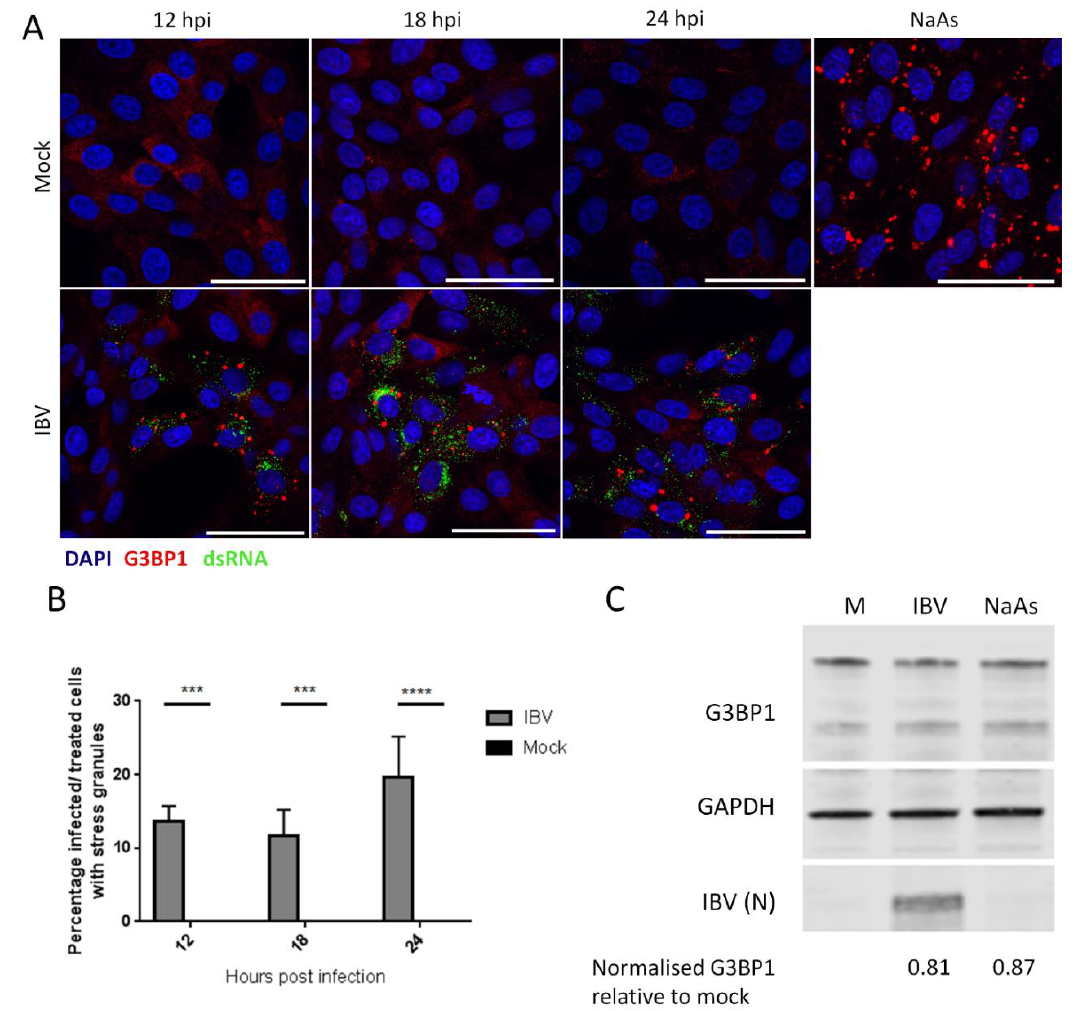
Figure 1. IBV (infectious bronchitis virus) infection induces stress granules in a proportion of infected cells. ( A ) Vero cells were mock infected or infected with IBV. At 12, 18 and 24 hpi, stress granules (SG) were detected using an anti-G3BP1 antibody (red) and IBV infection was detected with an anti-dsRNA antibody (green). Nuclei were stained with DAPI (blue). Positive control cells were treated with sodium arsenite (NaAs) to induce eIF2 α -dependent SG. Scale bar indicates 50 µ m. ( B ) Images in ( A ) were quantified by manual counting of SG positive cells, identified by counting infected or treated cells with G3BP1 foci. A minimum of 100 cells were counted from three independent replicates. The mean and standard deviation is shown. Asterisks indicate statistical significance, as measured by one-way ANOVA, *** represents p < 0.005 and **** represents p < 0.0005, respectively. ( C ) Vero cells were mock infected or infected with IBV. At 23 hpi, where indicated, cells were treated with NaAs. Cells were lysed at 24 hpi and processed and labelled using anti-G3BP1, anti-GAPDH or anti-IBV antibodies. Mean G3BP1 band intensities for IBV and NaAs treatments were normalized relative to mock band. Blot representative of 3 independent replicates.